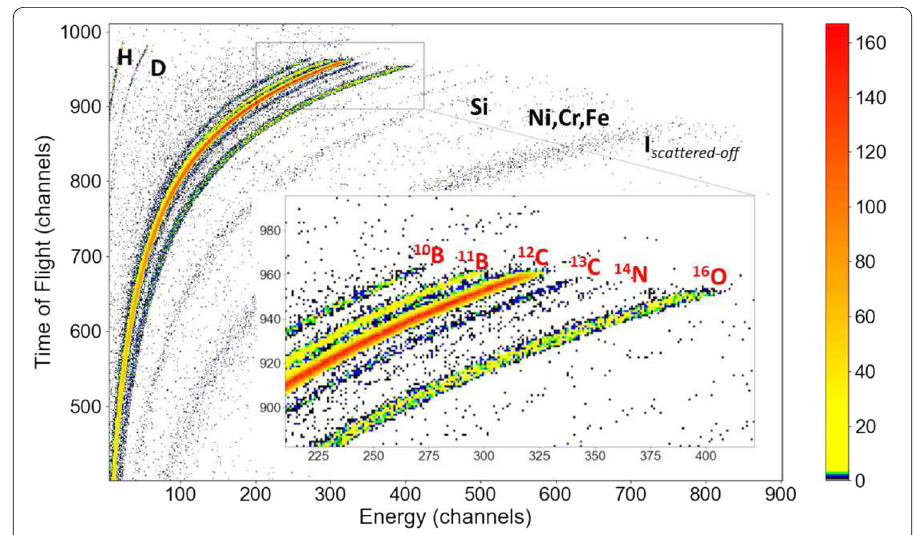
Figure 8 HIERDA spectrum for a PFC from the boronised TEXTOR tokamak after experiments involving the 13 C marker and edge cooling with 14 N 2 puffing